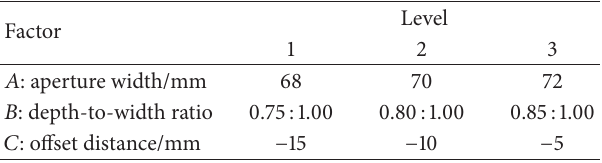
Table 2: The parameters of the orthogonal experiments.